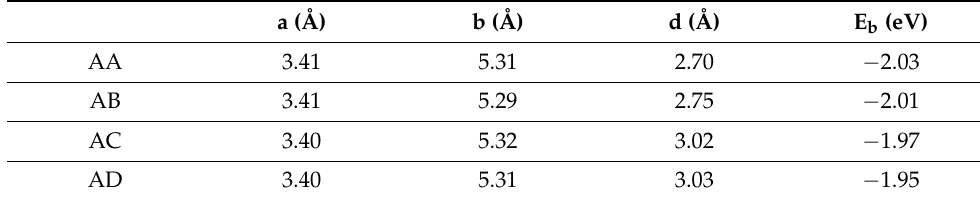
Figure 1. Four type of stacking configurations of the α -AsP/ γ -AsP homojunction: ( a ) AA-stacking, ( b ) AB-stacking, ( c ) AC-stacking, and ( d ) AD-stacking. The orange and purple balls in the picture represent As and P atoms, respectively. Table 1. The lattice constant a (Å) and b (Å), interlayer distance d (Å), and binding energy E b (eV) of α -AsP/ γ -AsP homojunction with four types of stacking configurations.